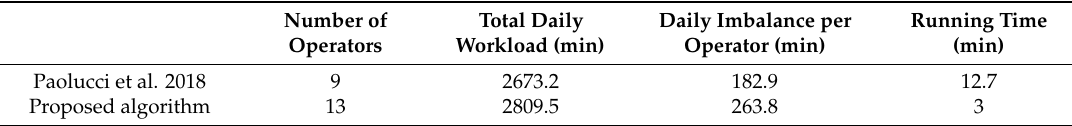
Table 7. Comparison between the previous and the current